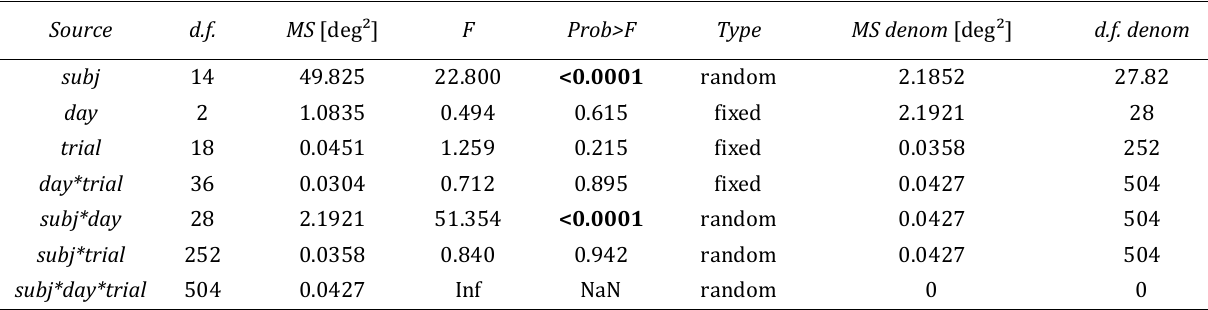
Table 1: Repeated measures ANOVA on the automated alternating cover test in Exp. 1 with the fixed factors day (1-3) and trial (1-19): Source